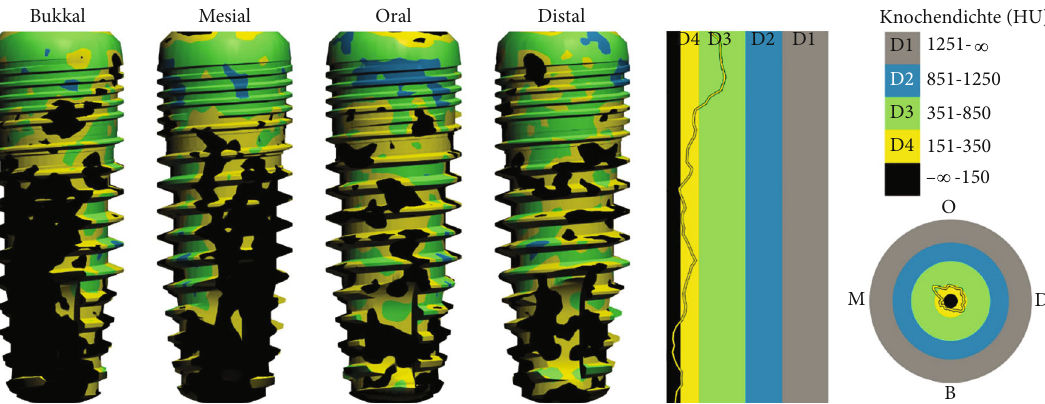
Figure 5: Example: simulation with mainly cylindrical implant (SICmax).